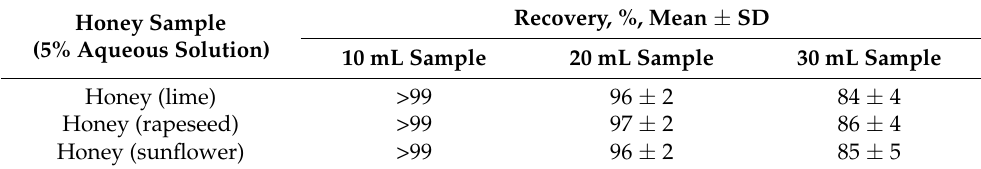
Table 7. Recoveries for U determination in honey samples, pH = 7 (three parallel determinations). Honey